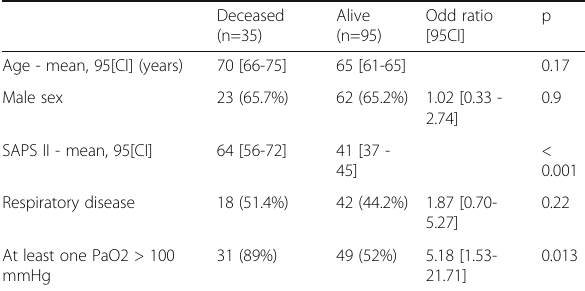
Table 1 (abstract 0214). Mortality risk factor in medical ICU, multivariate analysis